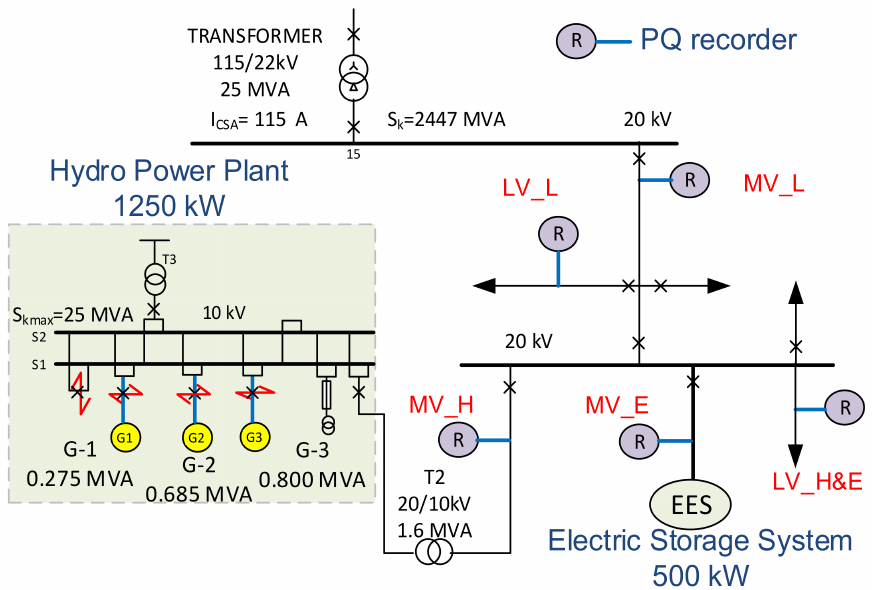
Figure 2. The virtual power plant (VPP) fragment with the power quality (PQ) recorders’ placements, where: MV_L: medium-voltage line that connects the hydropower plant (HPP) and energy storage system (ESS) to the 110/20 substations; MV_H: 1250 kW HPP; MW_E: 500 kW ESS; LV_L: a low- voltage load related to MV_L; LV_H&E: a low-voltage load related to the HPP and EES substation.